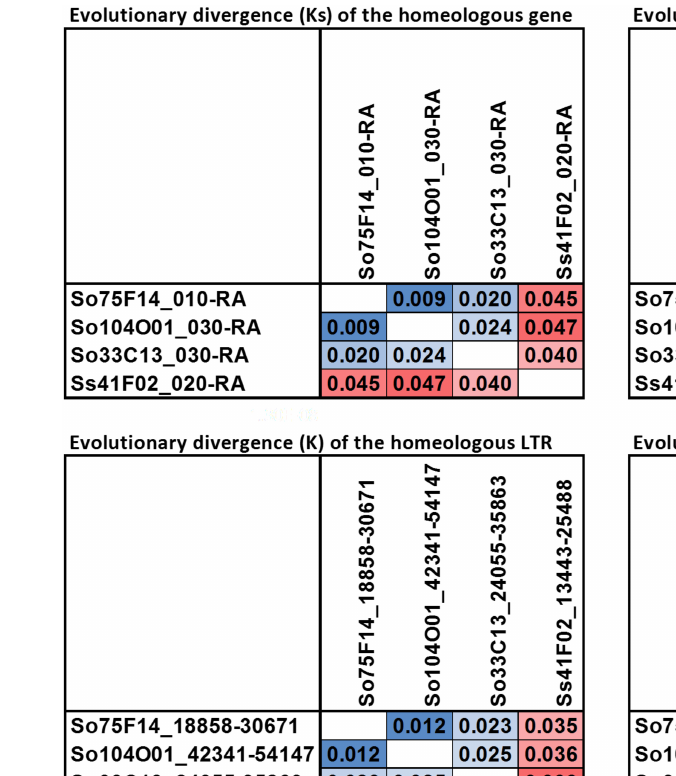
S. officinarum and S spontaneum at 1.5 mys. Our result does